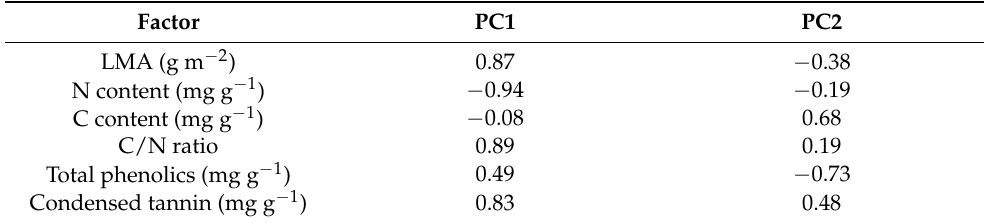
Table 2. Factor loadings of principal component